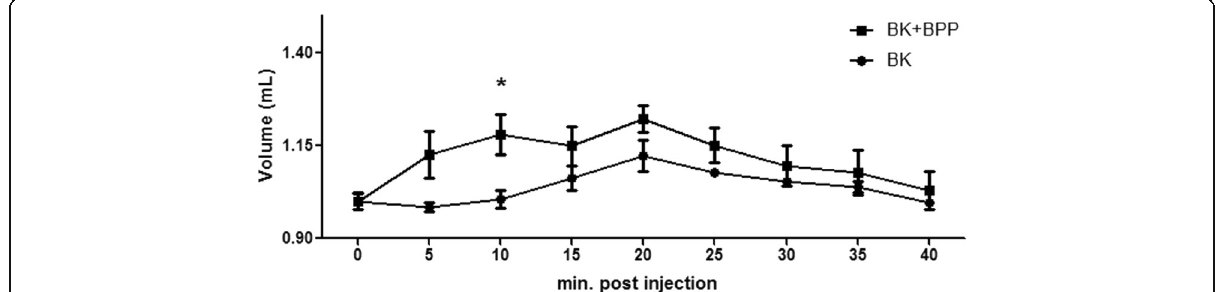
Fig. 5 Rat paw edema induced by BK and BK in the presence of BPP-10